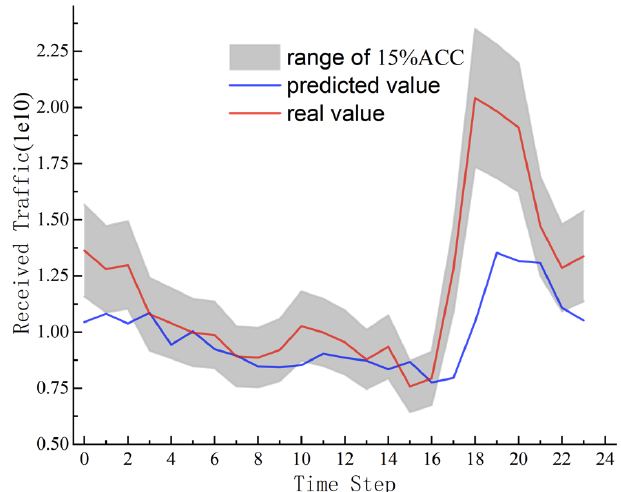
Figure 8. TCAG model prediction results.